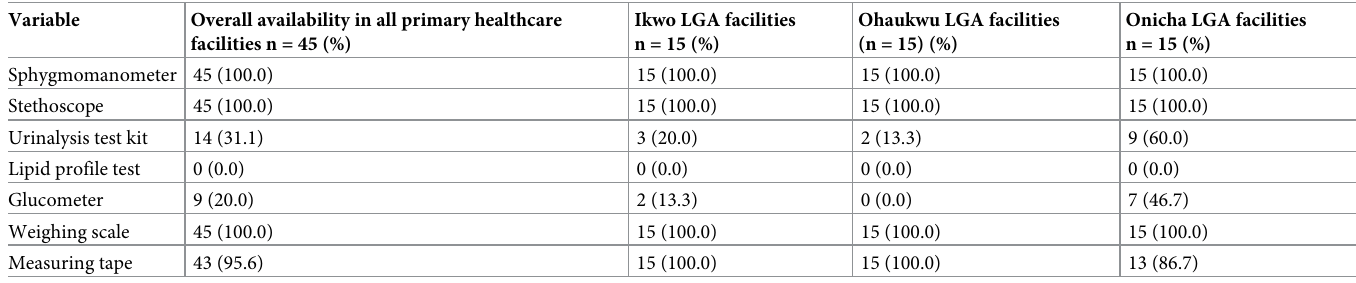
Table 2. Availability of technology for control of hypertension in primary healthcare facilities in Ebonyi State, Nigeria.